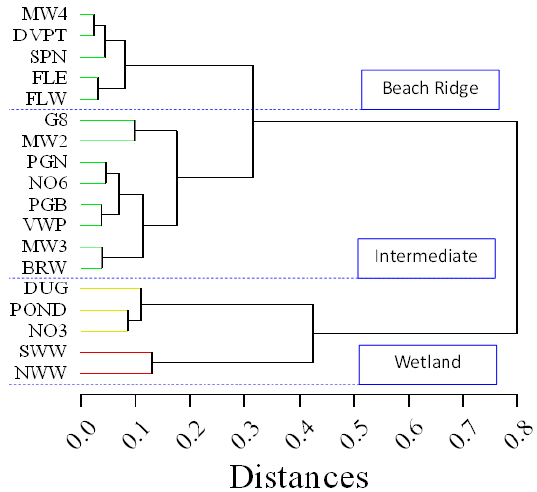
Figure 5. Dendrogram showing the Q-mode clustering of the groundwater data Fig. 5. Dendrogram showing the Q-mode clustering of the ground- water data.